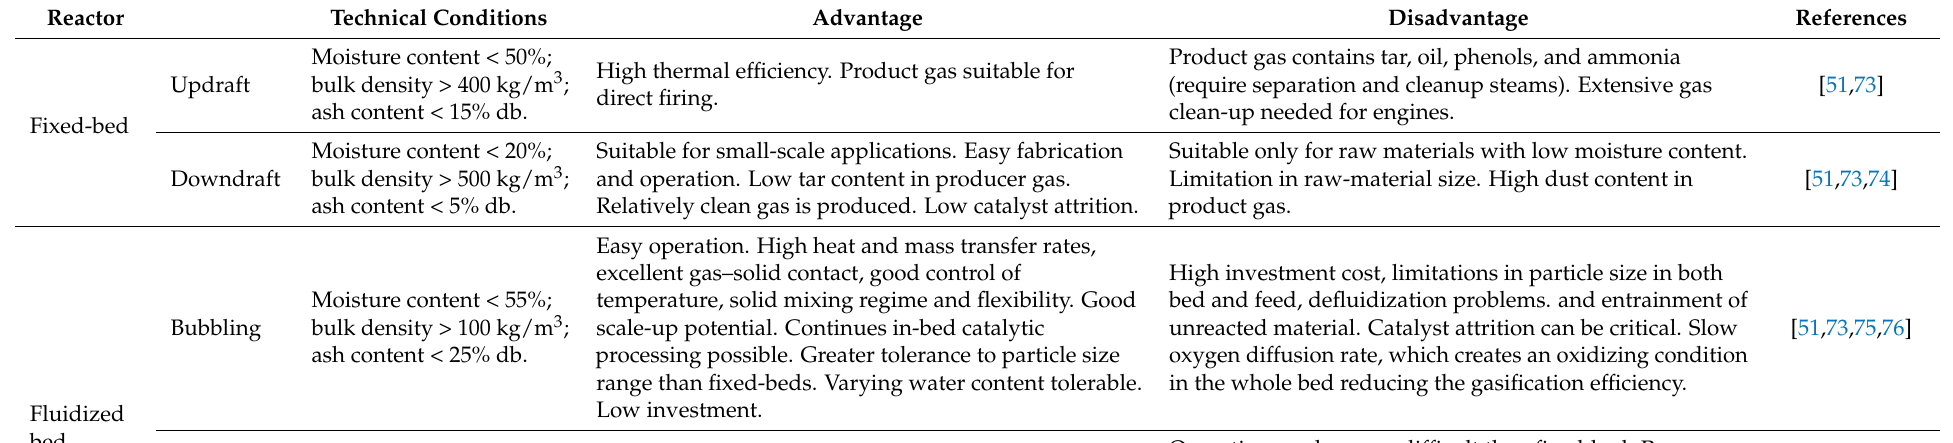
Table 4. Comparation among gasifier reactors (db—dry